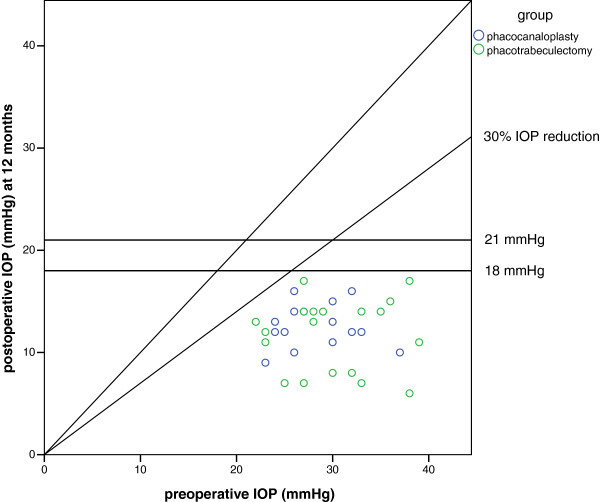
Scatter plot of preoperative intraocular pressure (IOP) compared to postoperative IOP at the 12-month visit. Each circle indicates a patient. Points below the oblique line define a lower postoperative IOP than baseline.